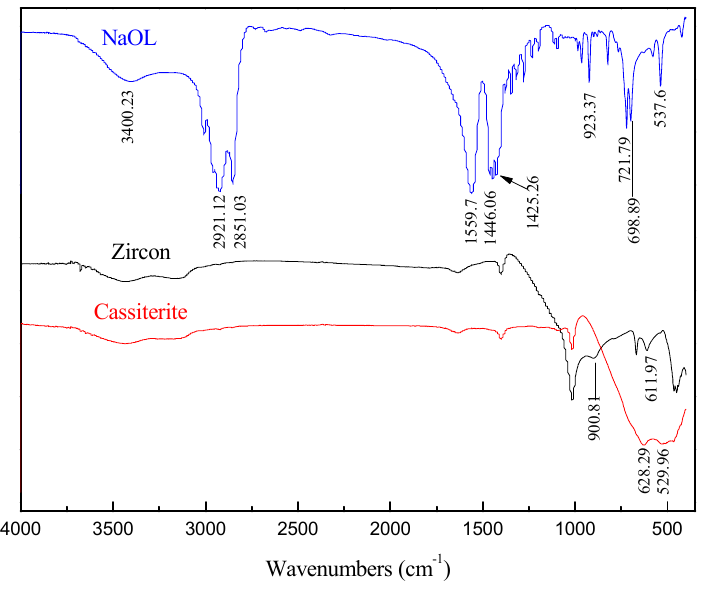
Figure 16. FTIR spectra of NaOL, cassiterite and zircon.